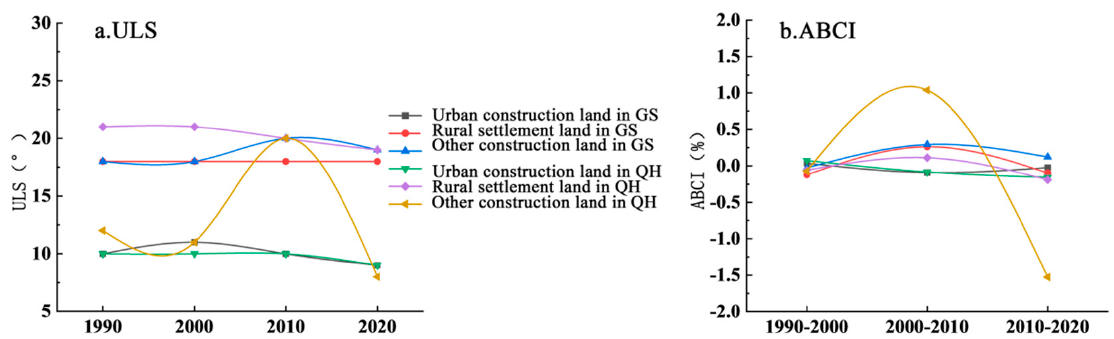
Figure 12. ABCI and ULS results of two regions within the LXUA from 1990 to 2020.